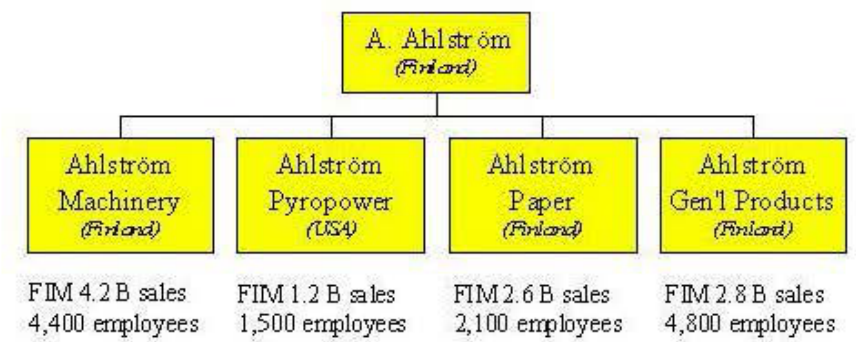
Figllre 10. Ahlstriiln Company di.visions, c. 1993